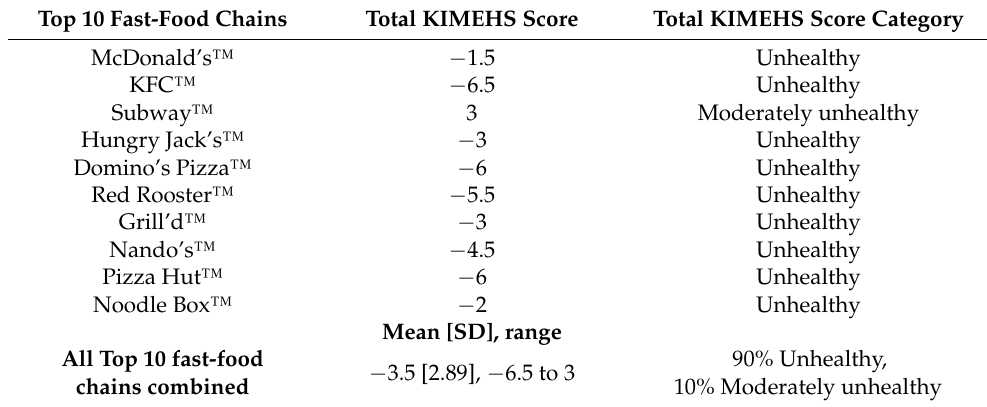
Table 6. Nutrition assessment of the top 10 fast-food chain Kids’ Menu items using the Kids’ Menu Healthy Score